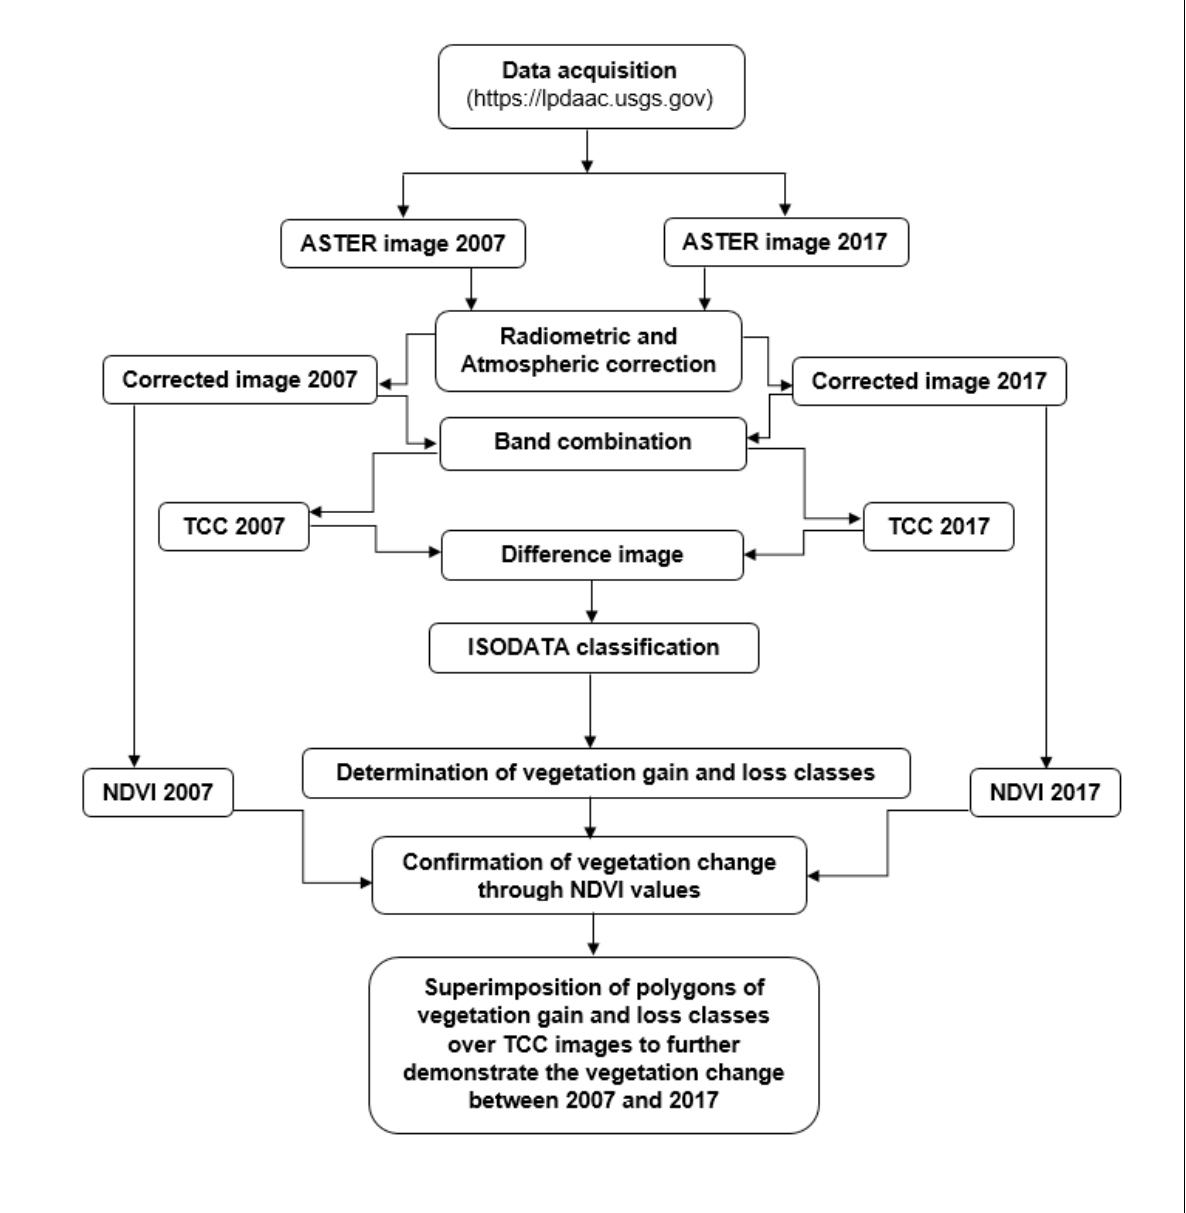
Figure 1: Flow chart of the methodology implemented in this